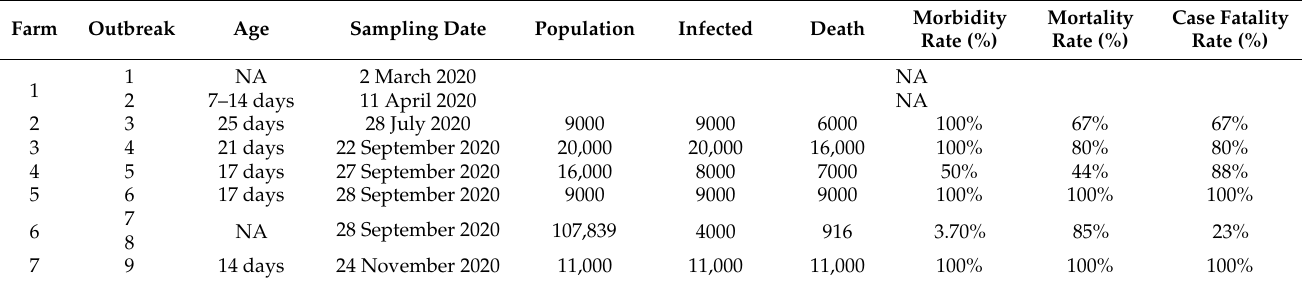
Figure 3. ( A ) The heart—accumulation of clear, straw-colored fluid in the pericardial sac (blue arrows). ( B ) The liver—pale, necrotic enlarged and friable (blue arrow). ( C ) Spleen—enlargement, congested and mottled spleen. ( D ) Kidneys—enlargement, congested, pale prominent tubules.